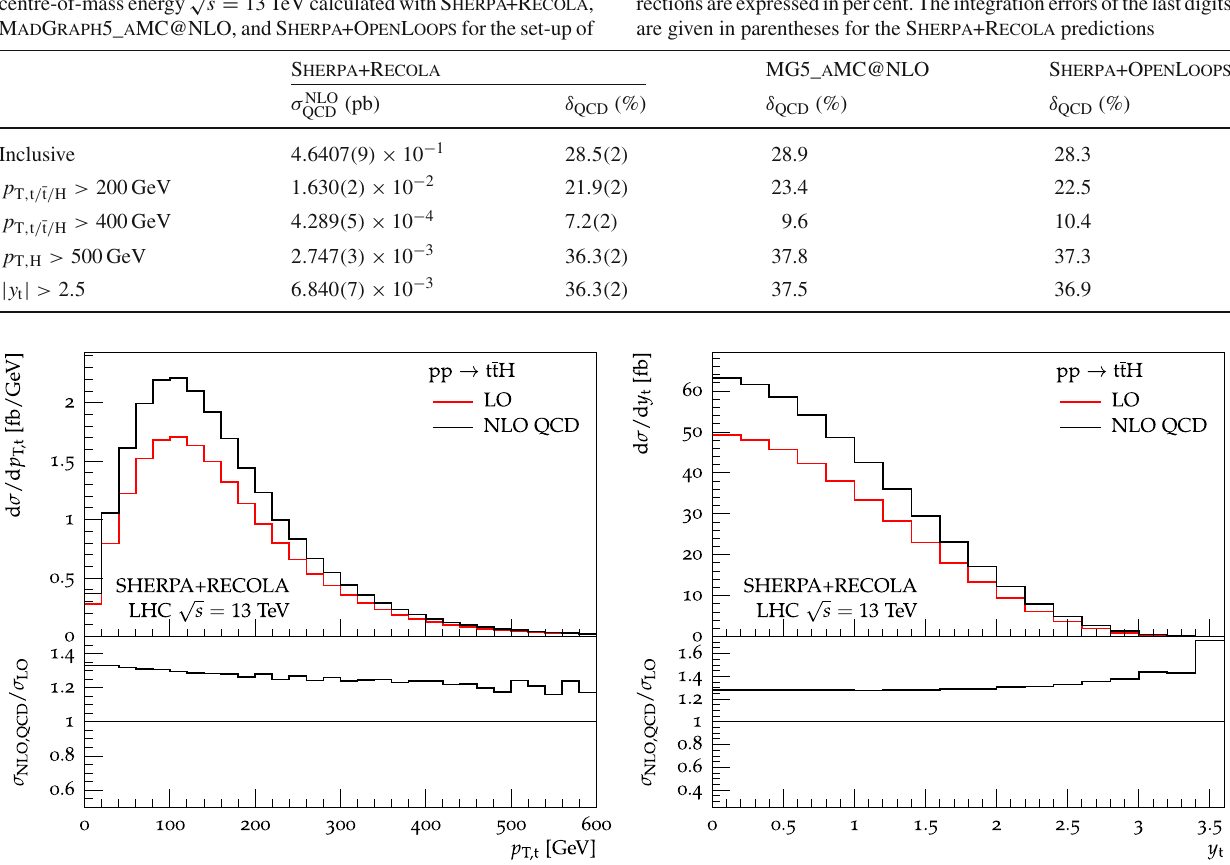
√ s = 13TeVforpp → t ¯ tHattheLHCinafullyinclusiveset-up:transversemomentum